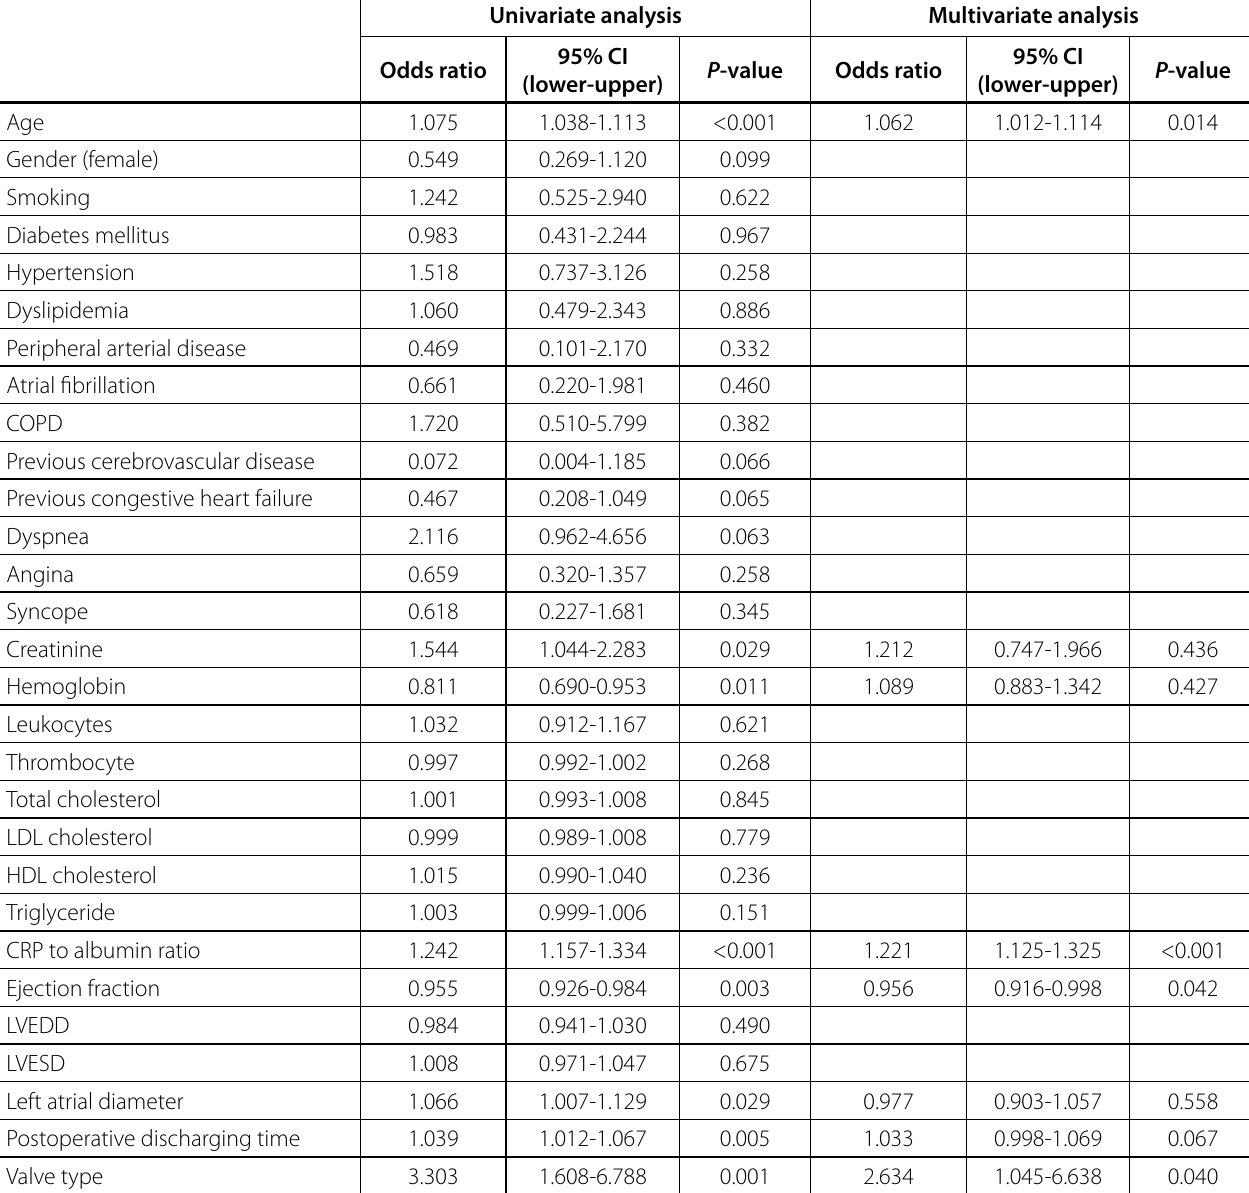
CI=confidence interval; COPD=chronic obstructive pulmonary disease; CRP=C-reactive protein; HDL=high-density lipoprotein; LDL=low-density lipoprotein; LVEDD=left ventricular end-diastolic diameter; LVESD=left ventricular end-systolic